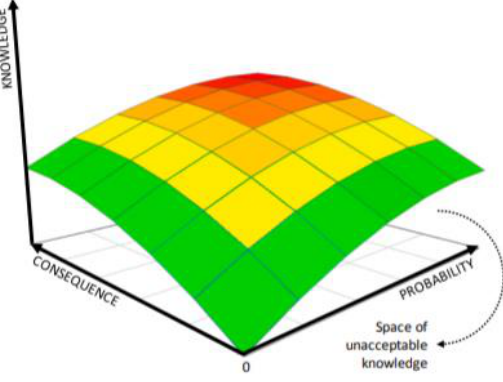
Figure 3. Risk matrix with knowledge dimension.